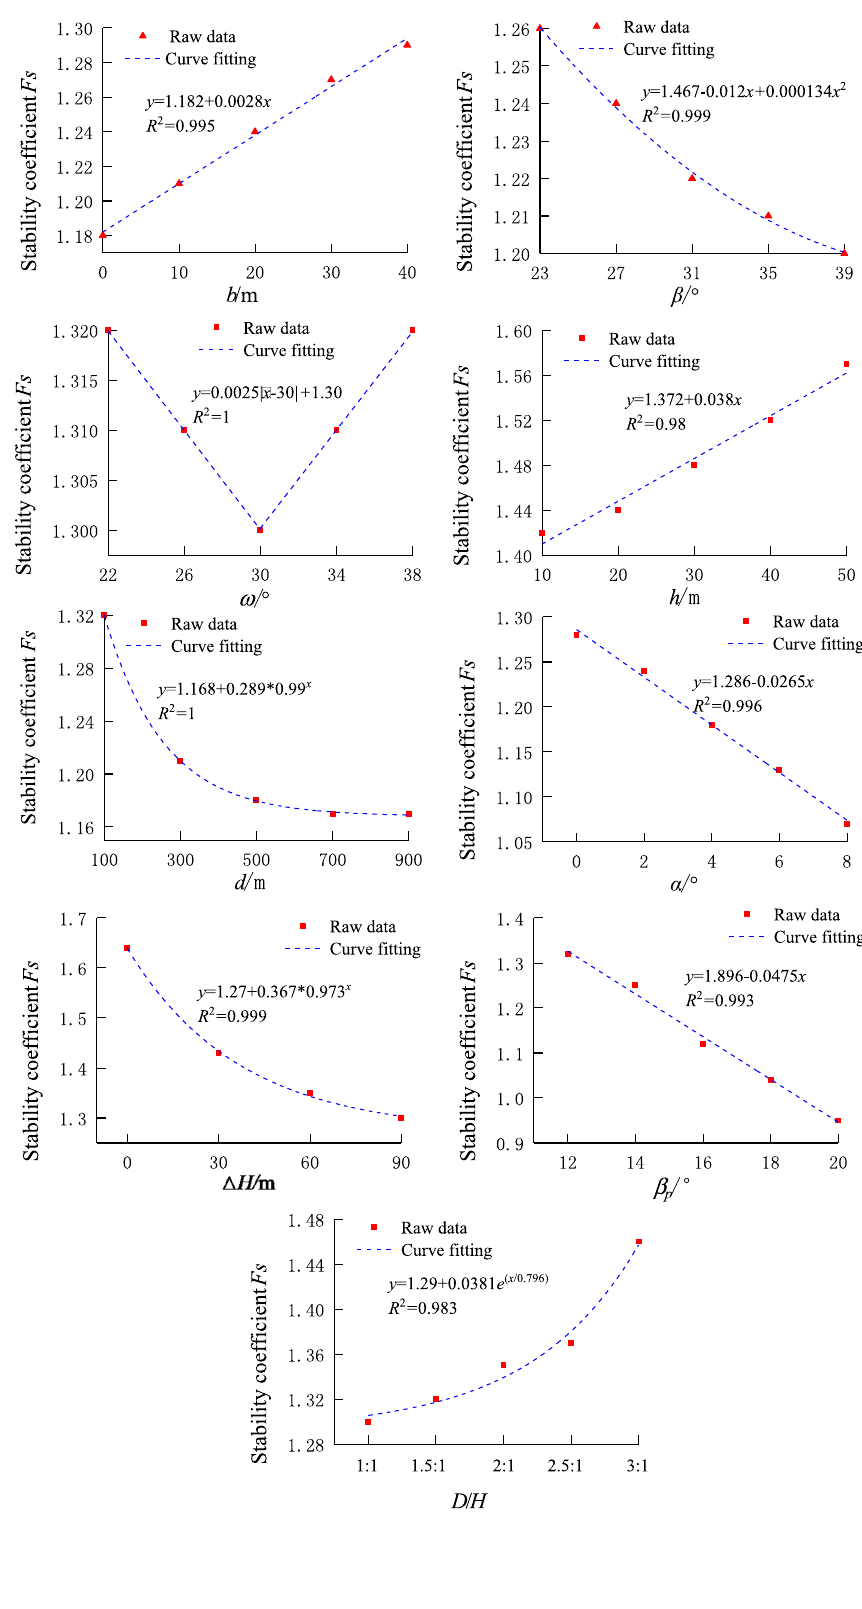
Fig. 11 Inner dump stability with respect to various factors (longitudinal intercept of the slope line of the inner dump is determined by the slope angle, the distance from the coal pillar to the slope toe, and the height of the inner